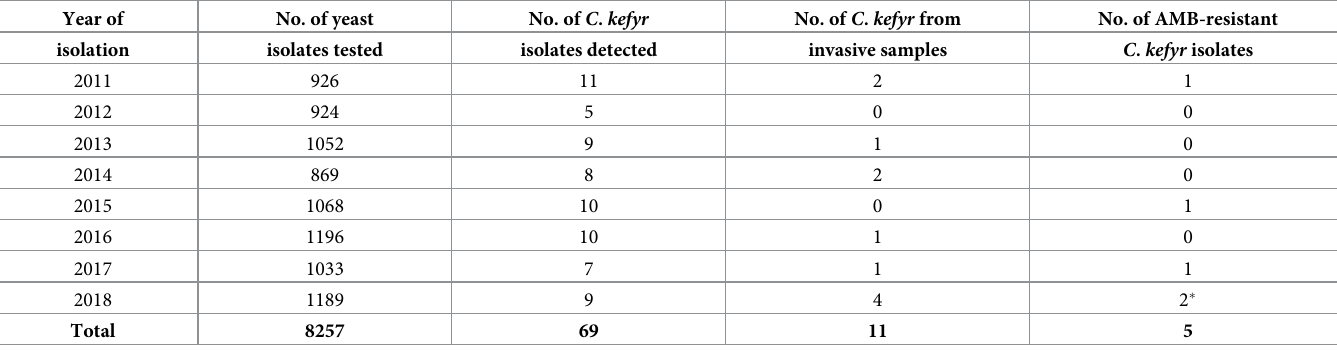
Table 1. Distribution of total, invasive and amphotericin B (AMB)-resistant C . kefyr strains detected among clinical yeast isolates collected during 2011–2018 in Kuwait. Year